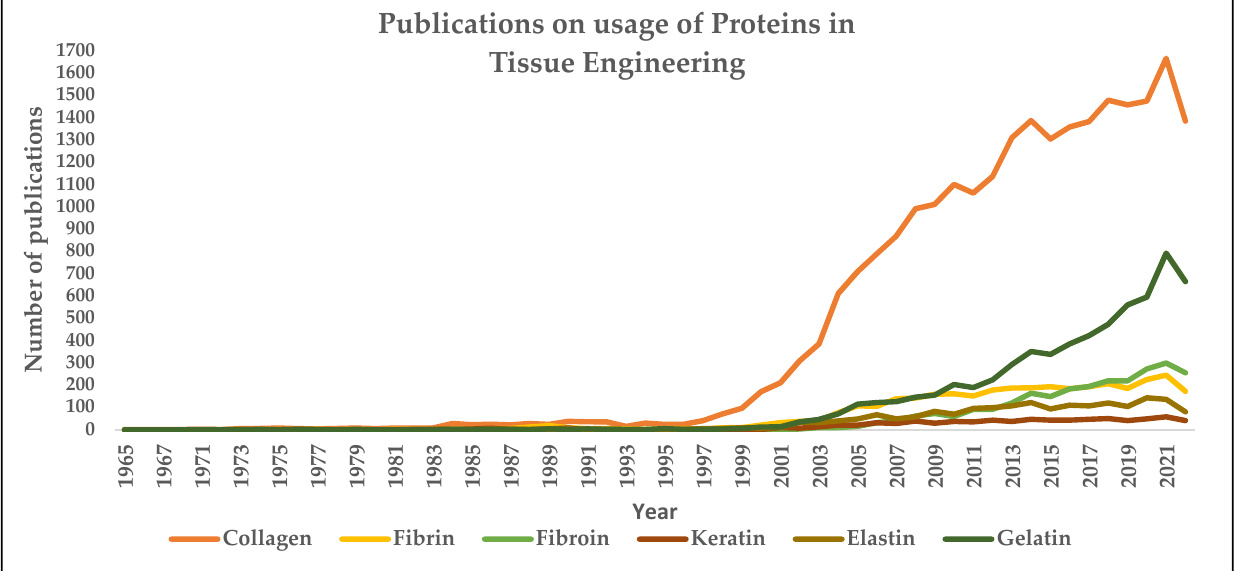
Figure 9. Publications on the usage of proteins in tissue engineering. (The number of papers published on individual proteins such as collagen, fibrin, fibroin, keratin, elastin, and gelatin is drawn based on the year and the respective total number of papers published, using search engine: www.scopus.com, accessed on 15 January